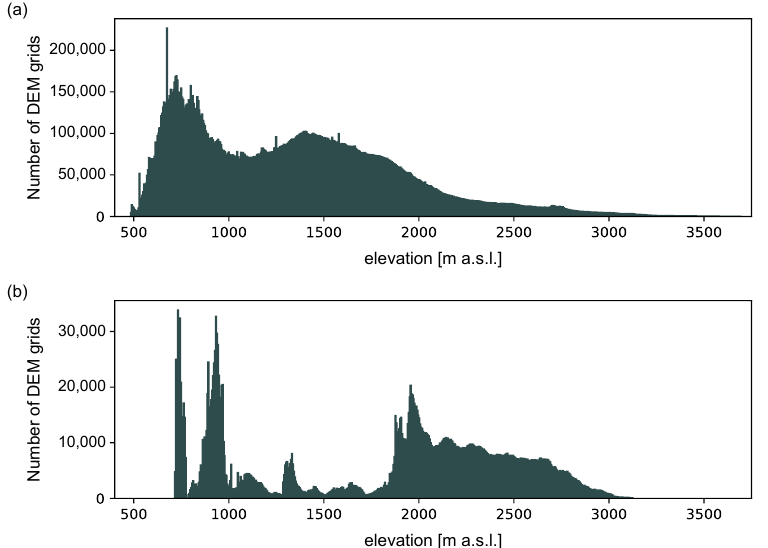
Figure 3. Histogram of the elevation range ( a ) of the whole study area and ( b ) of the area covered by the selected webcams. Note that for ( a ), a 10 m resolution digital elevation model (DEM) and for ( b ), a 2 m resolution DEM was used.